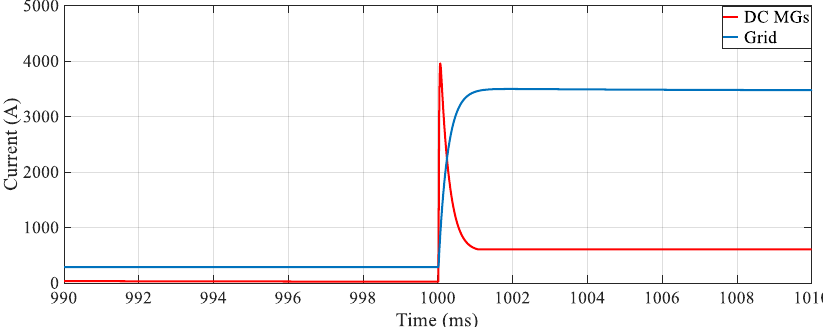
Figure 12. Fault current contributions without FCL, from grid and DC MGs.